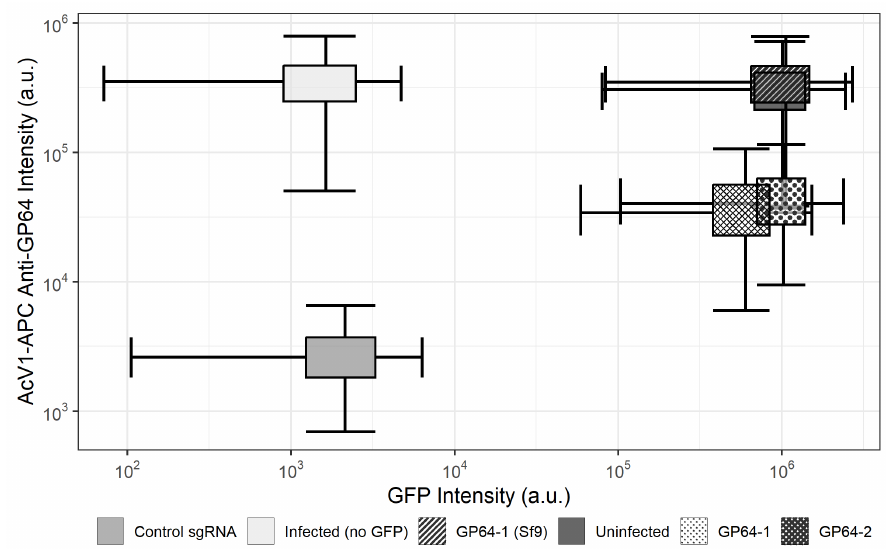
Figure 2. CRISPR-mediated disruption of gp64 reduces GP64 abundance in the membrane of Sf9-Cas9 cells compared to parental Sf9 cells. Fluorescence intensity for control and gp64 -targeted rBEVs expressing the reporter GFP ( x -axis) and stained with APC-conjugated anti-GP64 AcV1 monoclonal antibody ( y -axis) represented as a 2-dimensional boxplot. The width and height of the boxes represent the interquartile range (IQR) for the GFP and RFP distributions, respectively. The length of the whiskers are 1.5 × IQR . Uninfected control: uninfected cells; Infected Control: Infected with non-fluorescent control rBEV; Control: Sf9-Cas9 cells infected with untargeted sgRNA; GP64-1/GP64-2: Sf9-Cas9 cells infected with gp64 -targeted sgRNAs; GP64-1 (Sf9): parental Sf9 cells infected with GP64-1 rBEV. All samples were taken at 48 hpi.